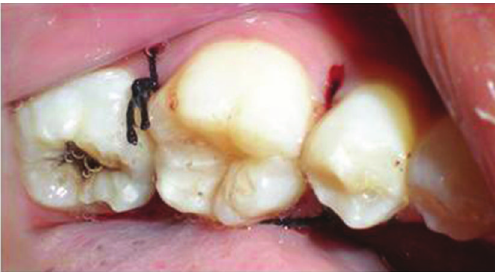
Figure 12: Completed immediate repair with 36 and sutures in place.